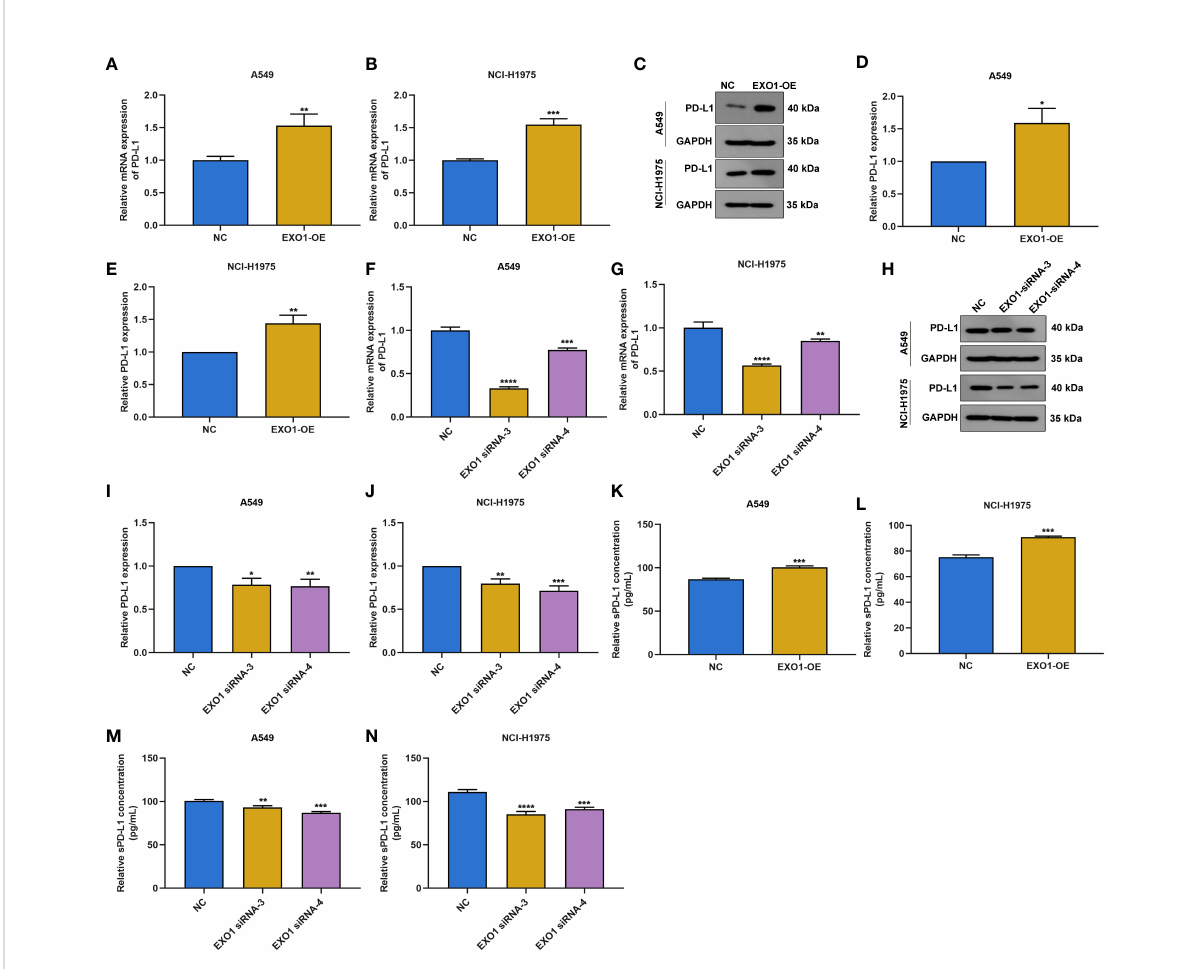
FIGURE 9 EXO1 facilitates PD-L1 and sPD-L1 expression in LUAD cells. (A – E) RT-qPCR and Western blotting of PD-L1 expression in A549 and NCI-H1975 cells with EXO1 overexpression. (F – J) RT-qPCR and Western blotting of PD-L1 expression in A549 and NCI-H1975 cells when EXO1 was knocked out. (K – N) ELISA for sPD-L1 levels in A549 and NCI-H1975 cells with EXO1 overexpression or knockdown. *p < 0.05; **p < 0.01; ***p < 0.001; ****p < 0.0001. LUAD, lung